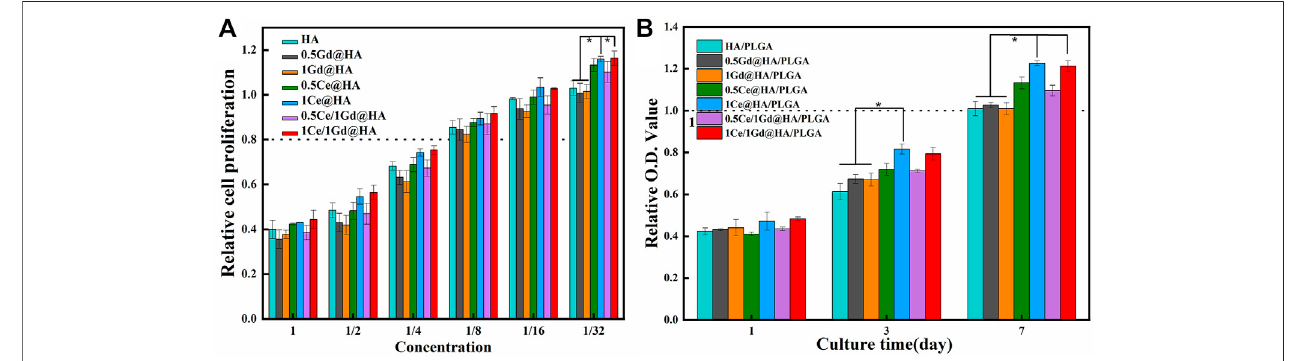
FIGURE 5 | (A) Proliferation of MC3T3-E1 cells cultured for 24 h in each solution of HA, 0.5Ce@HA, 1Ce@HA, 0.5Gd@HA, 1Gd@HA, 0.5Ce/1Gd@HA, and 1Ce/ 1Gd@HA nanoparticles with different concentrations. (B) CCK-8 assays of MC3T3-E1 osteoblasts on 1, 3, and 7 days by using different nanocomposites. * p < 0.05.